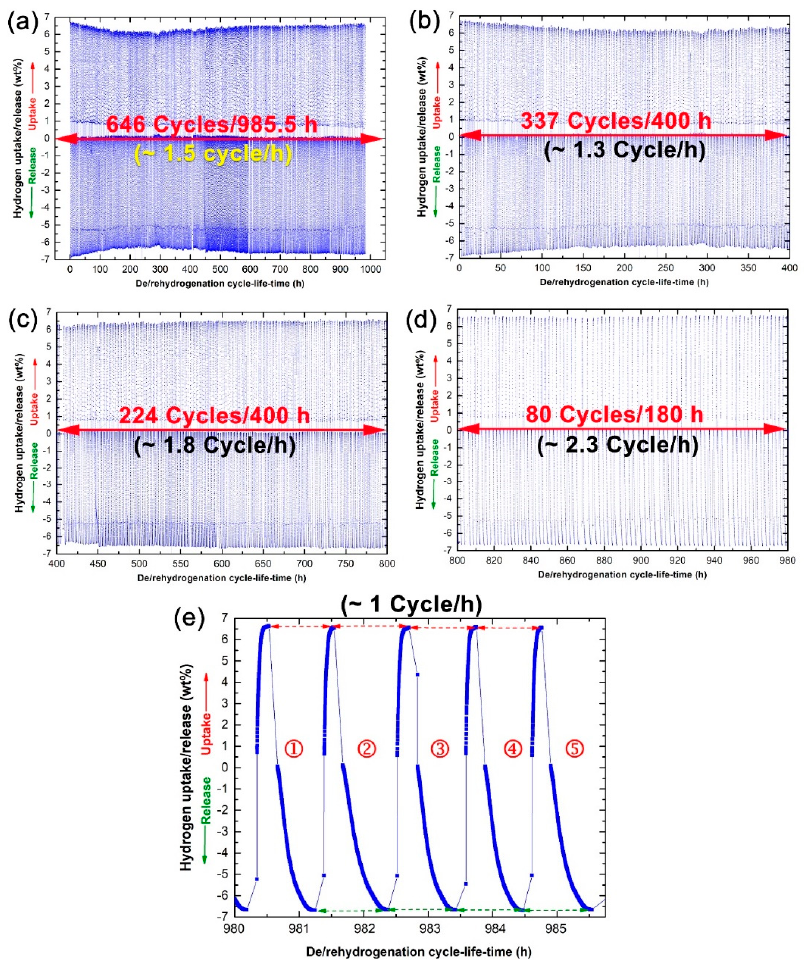
Figure 13. ( a ) Complete profile of cycle ‐ life ‐ time test conducted for 985.5 h (646 cycles) of 50 ‐ h MgH 2 powders milled with Zr 2 Ni balls. The cycle ‐ life ‐ time curves for the first and second 400 h are presented in ( b ) and ( c ) respectively, where the last 180 h is displayed in ( d ). The last five cycles of the test is presented in ( e ). All measurements were conducted at 225 ◦ C, with hydrogenation and dehydrogenation pressure of 10 bar and 200 mbar of hydrogen,